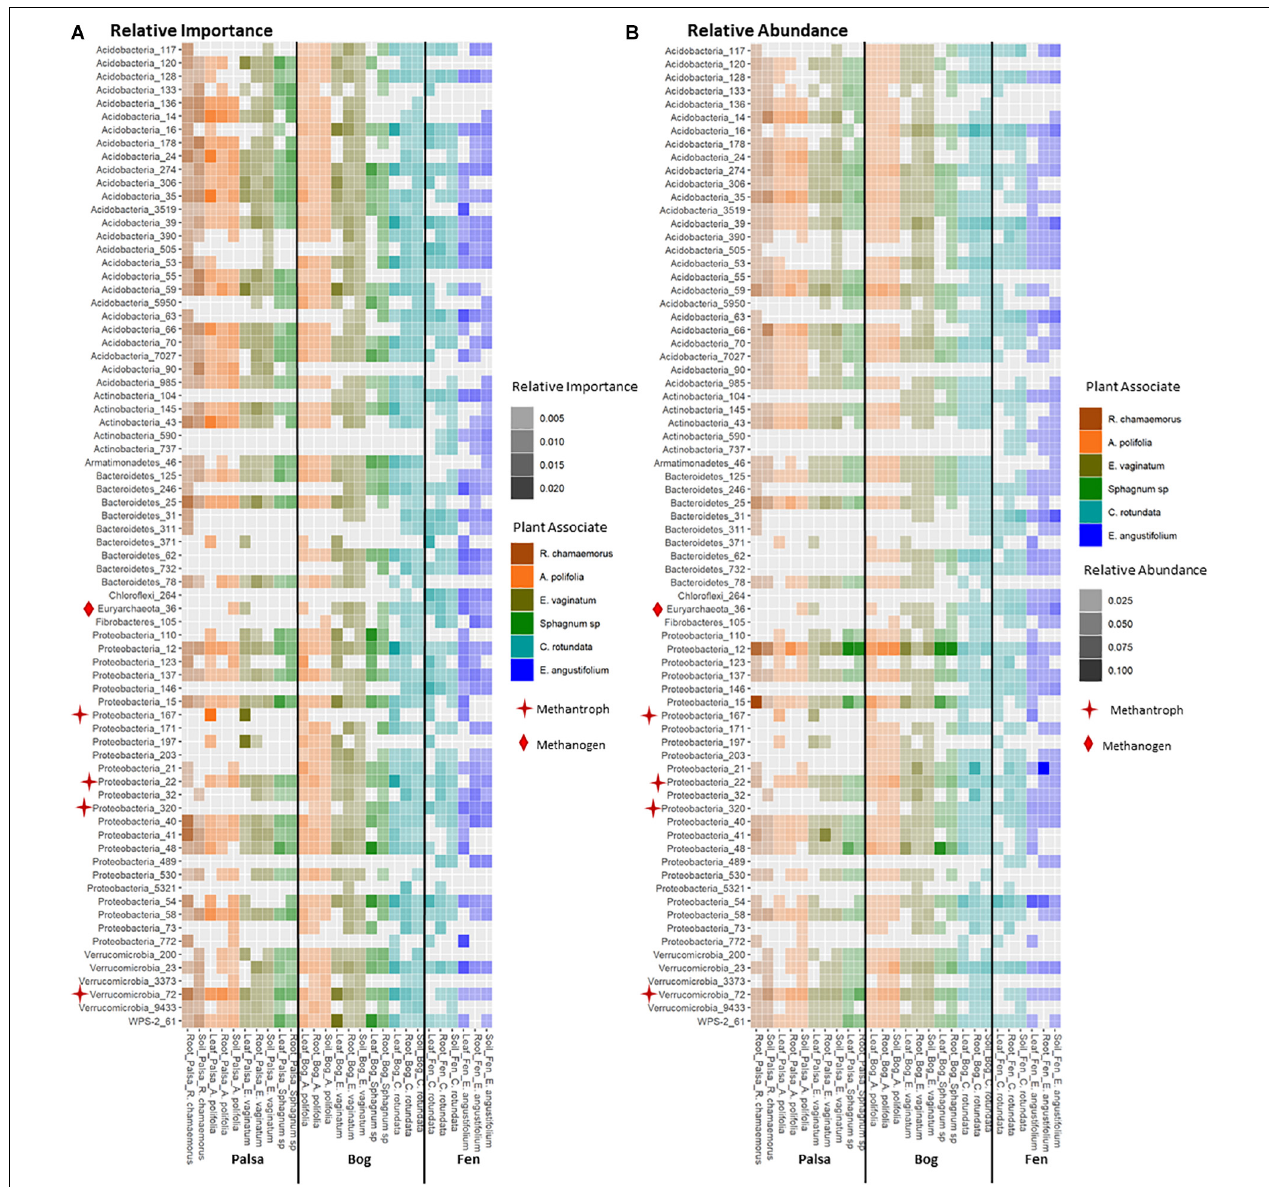
FIGURE 8 | Comparison of (A) relative importance and (B) relative abundance of organisms in the 99th percentile of importance to network structure across habitat, compartments, and plant associates. Stars indicate methanotrophs and diamonds indicate